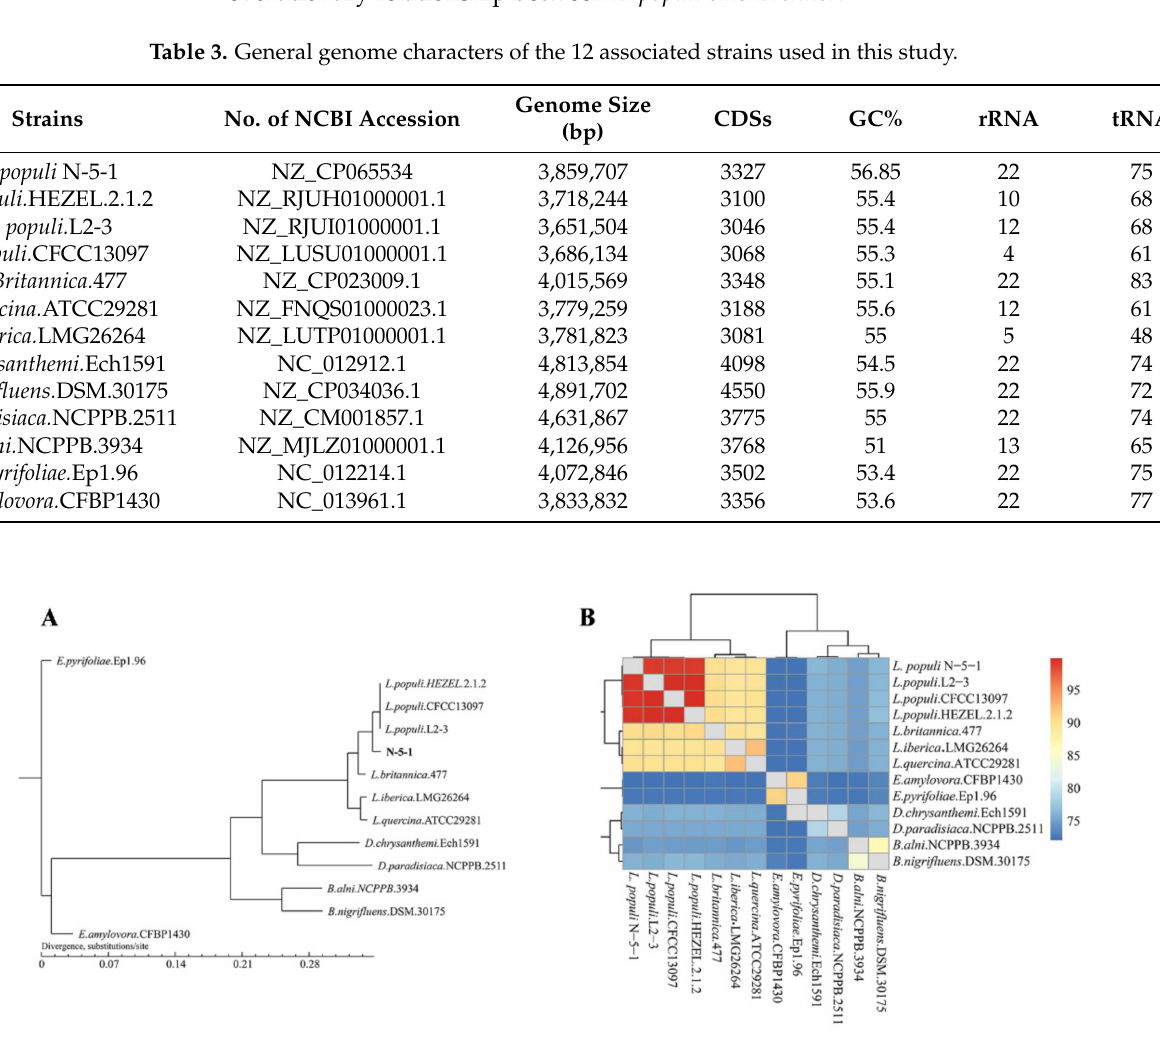
Figure 4. Phylogenetics of L. populi N-5-1 and related bacteria. ( A ) Phylogenetic tree constructed using TreeBeST with the neighbor-joining algorithm based on the core-pan gene. Orthologs were predicted via BLASTp-based genome searches. ( B ) Taxonomic thermograms of 13 strains based on the ANI, using online